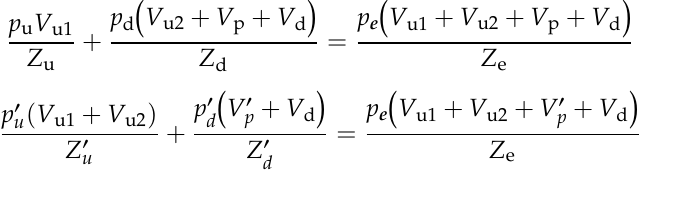
Figure 3. Pressure data points in estimating total porosity and secondary accessible porosity in a pulse-decay experiment.